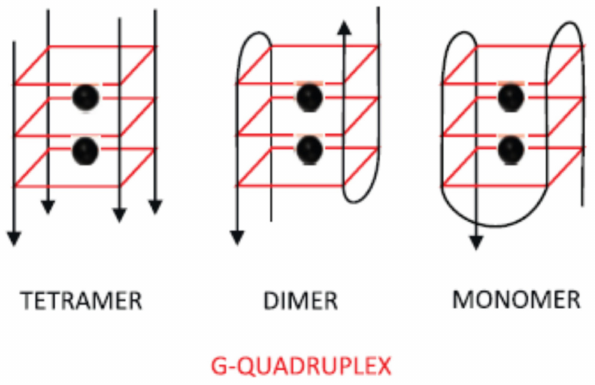
Figure 2. Schematic representation of tetramer, dimer and monomer G-quadruplex structures. The black balls represent the cations that stabilize the structure. Reprinted and adapted from reference [24] with permission from